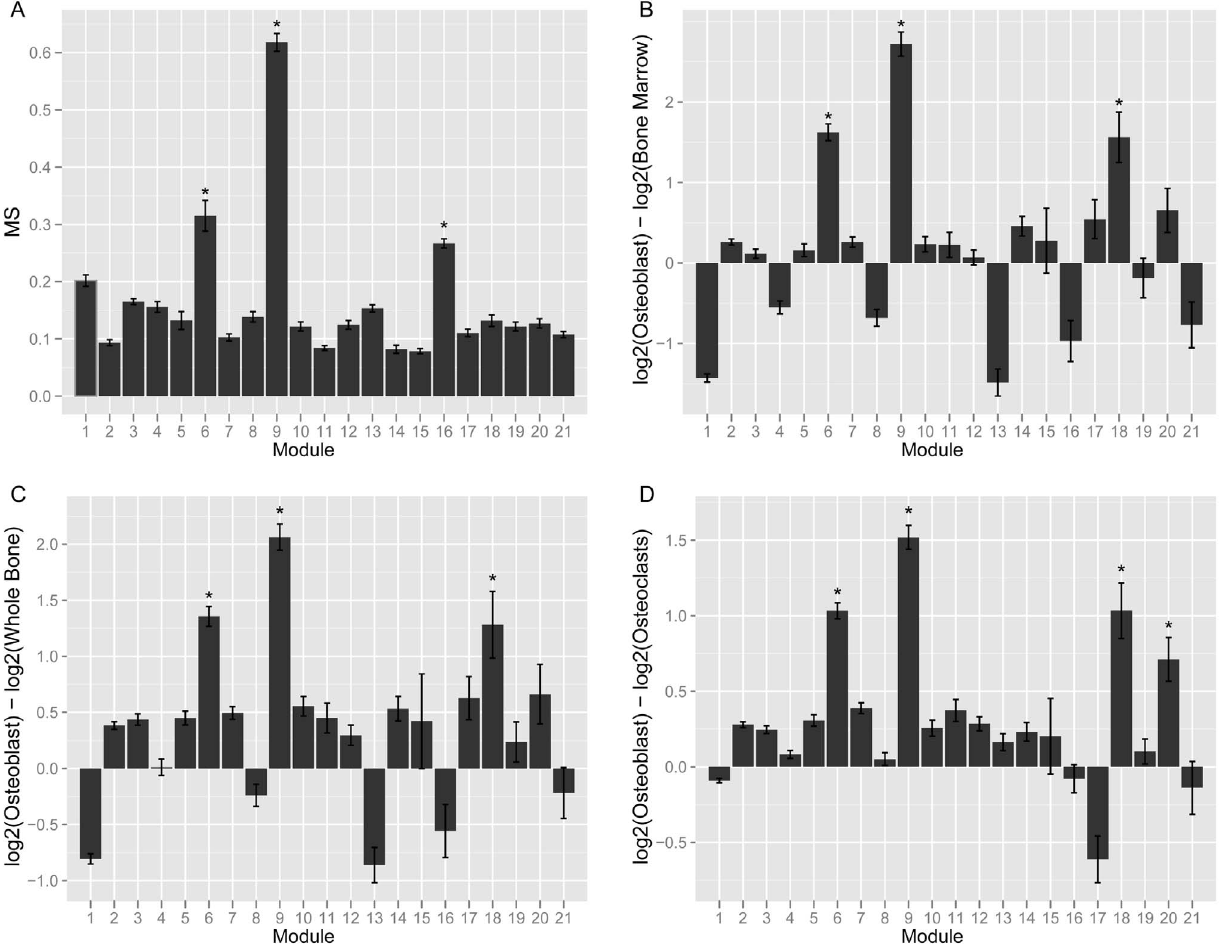
Figure 1. Module 9 is a co-expression network specific to cells of the osteoblast-lineage. (A). Mean MS score for each of the 21 network modules. (B) Mean module gene expression in osteoblasts relative to bone marrow. (C) Mean module gene expression in osteoblasts relative to whole bone. (D) Mean module gene expression in osteoblasts relative to osteoclasts. In panels (B–D) expression is presented as the mean log2 expression for each gene in a module in osteoblasts minus log2 expression in the second sample. *Bonferroni adjusted P , 0.002.